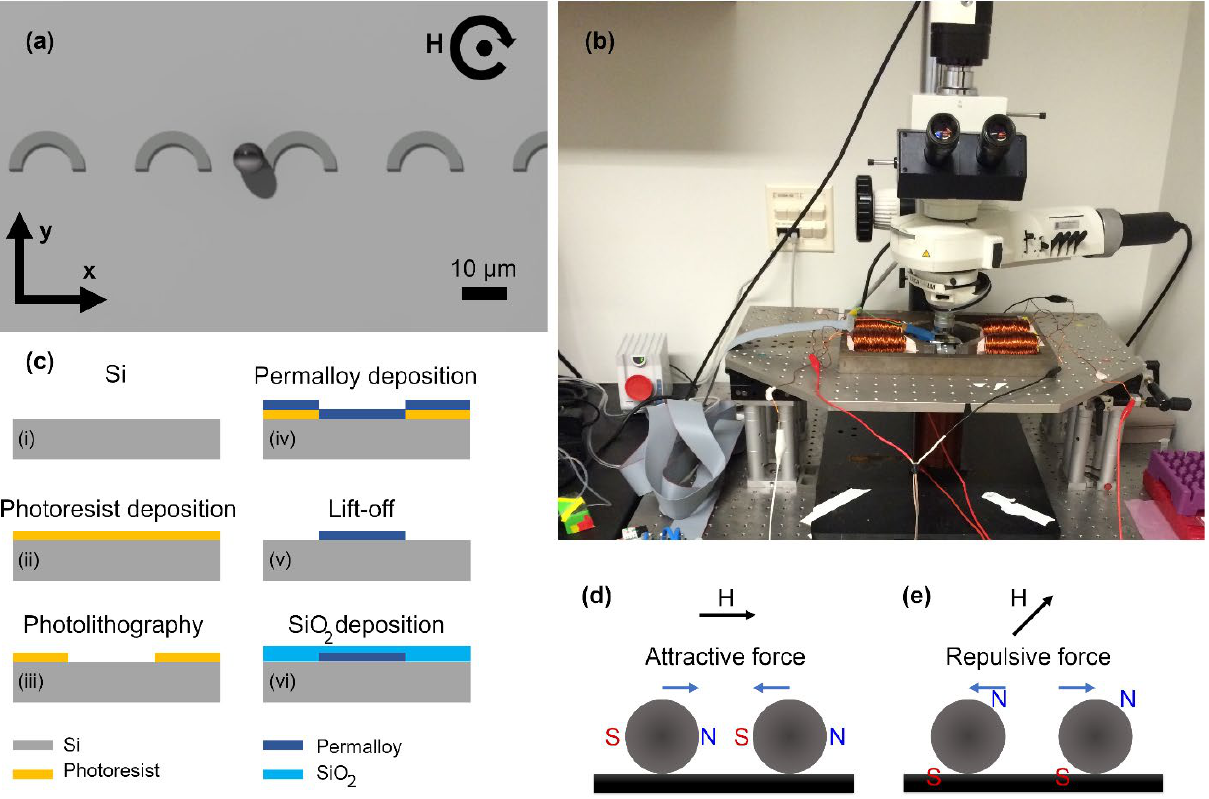
Figure 1. ( a ) A schematic of the proposed C-shaped design is illustrated. The little sphere represents a particle. The circular arrow and the dot in the middle stand for the in-plane rotating field and the vertical bias field, respectively. ( b ) The experimental setup is shown. ( c ) A schematic of the fabrication steps is presented. (i) We start with a silicon wafer. (ii) A photoresist layer is deposited on wafers. (iii) Using photolithography, the photoresist layer is patterned. (iv) Then a thin layer of permalloy evaporated onto the surface. (v) Next, after a liftoff process the unwanted metal is removed. (vi) Finally, the chip is coated with a thin layer of SiO 2 . ( d ) In an in-plane field, the force between magnetic particles is attractive (side view). ( e ) Adding a vertical bias field to the in-plane field, turns the force between magnetic particles into a repulsive force (side view). In ( d , e ), the circles and the black rectangle stand for the particles and the substrate, respectively. The black and blue arrows stand for the external magnetic field and the force directions, respectively. N and S represent the north and south poles of the magnetic dipole